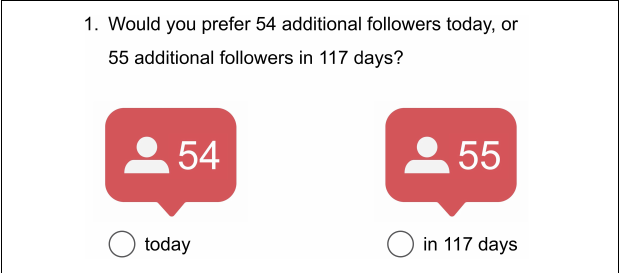
FIGURE 1 | Exemplary choice trial from the delay discounting task for followers.